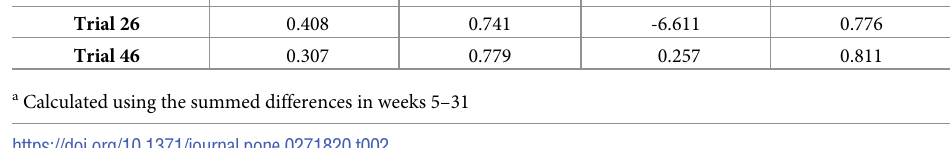
HFMD patients based on the modified 2014 and 2015 data were compared with the simulation results (weeks 9–31) based on the unmodified data. After summing the differences between the results obtained before and after modifying the input data, we found that among 47 prefec- tures, replacing the number of patients in Osaka Prefecture maximized the variability of the simulation. The results of other urban areas (Tokyo, Aichi, and Fukuoka) were less variable than those of Osaka (Figs 6 and 7). Moreover, the patient numbers began increasing earlier in Osaka Prefecture than in other prefectures during the actual HFMD outbreak of 2015 (Fig 8).